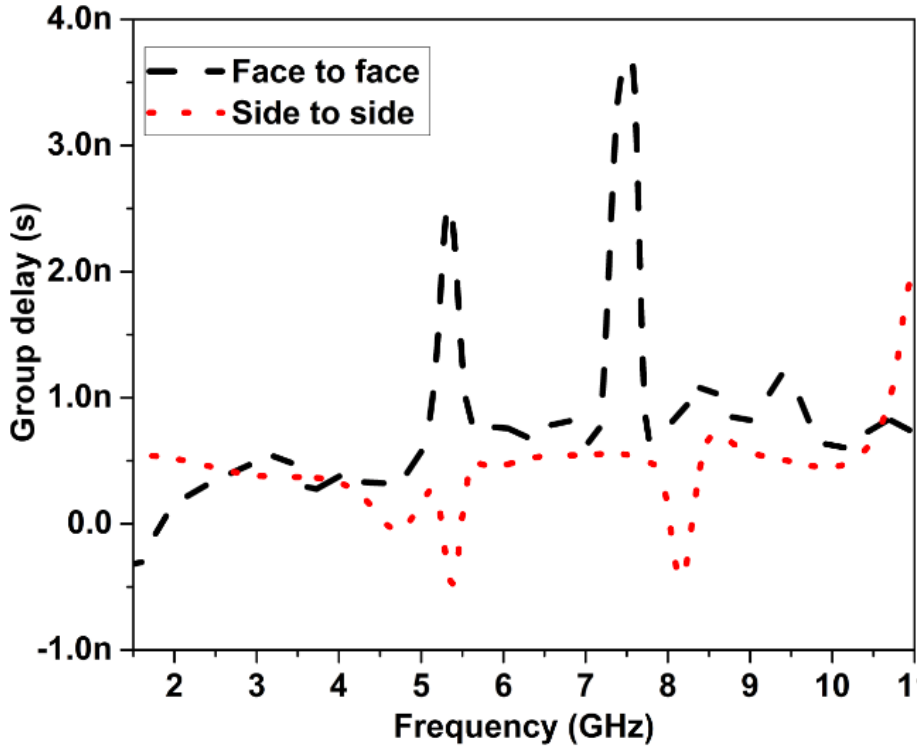
Figure 25. Group delay of proposed UWB notch antenna.